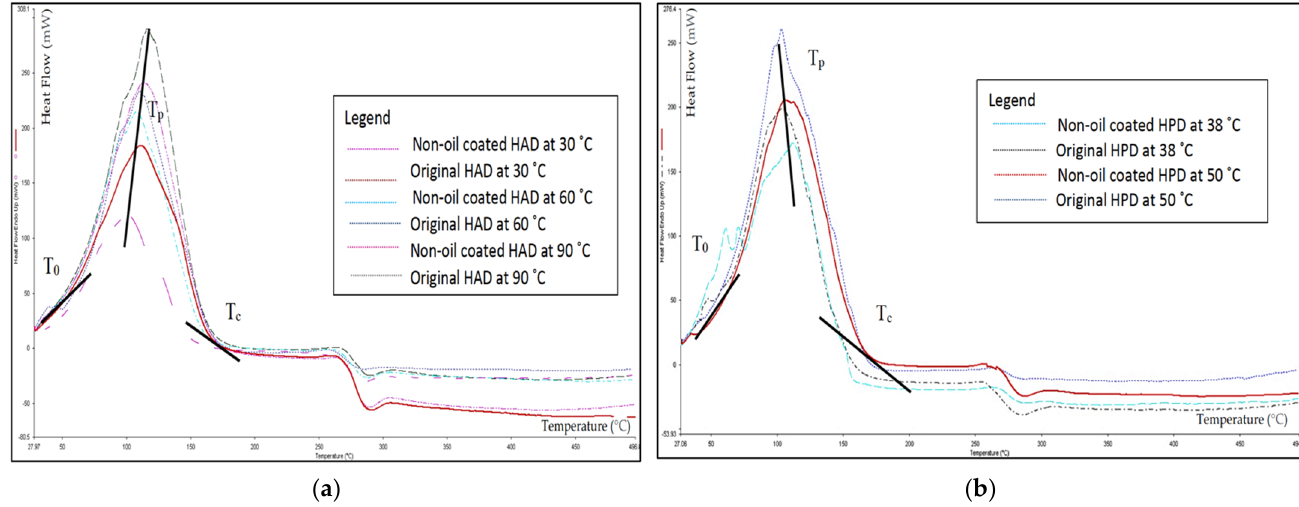
Figure 2. Fat content of rice noodle at hot air drying (HAD), heat pump drying (HPD) and freeze drying (FD). Means of fat content that do not share a letter in the figure are significantly different. The overall gelatinization process can be described by three temperatures: the start of gelatinization (T o ), a peak temperature (T p ), and when gelatinization ceased (T c ), as shown in the temperature (°C) against heat flow (mW) in Figure 3.